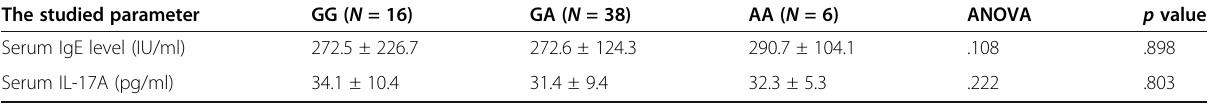
All paramete represented as mean and